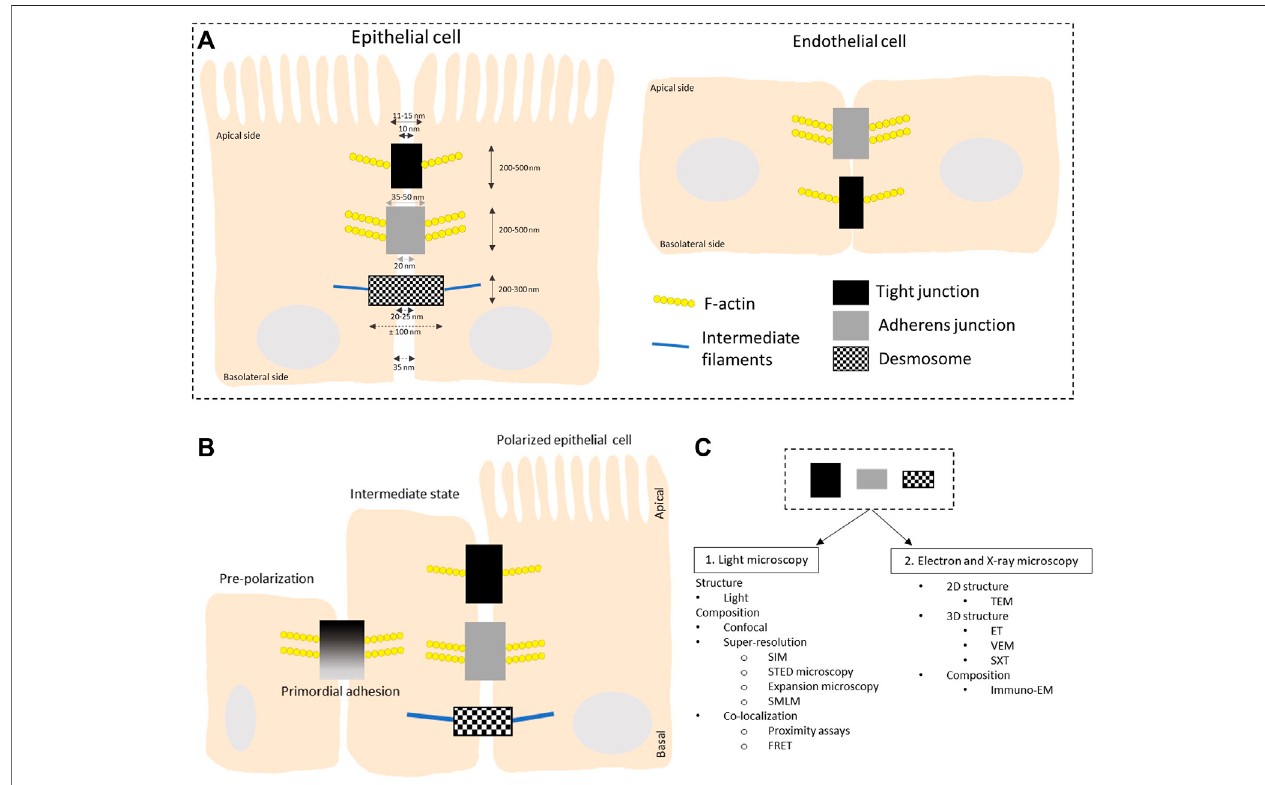
FIGURE 1 | Schematic overview of the organization of intercellular junctions in epithelial and endothelial cells. (A) Tight junctions, adherens junctions and desmosomes are present in polarized epithelial cells while no desmosomes are found in fl at endothelial cells. Tight and adherens junctions are connected to the actin cytoskeletonwhiledesmosomesconnecttointermediate fi laments. (B) Organizationofintercellularjunctionsduringthepolarizationofepithelialcells.Intheinitialstageof polarization, proteins like afadin and nectins are present. They recruit E-cadherin and junctional adhesion molecules (JAMs) to the lateral cell-cell contacts, called theprimordialadhesionsinimmatureepithelialcells.Thesematuretoformbelt-likeadhesionjunctionsandtightjunctionslocalizedattheapical-basalmembraneborder. The mechanism behind the polarization isreviewed in (Martin-Belmonte and Perez-Moreno,2012).The overallheight ofapolarized cellgrown in vitro is~15 μ m, fi gures are not on scale. (C) Overview of the different microscopy techniques that are discussed in this review to study the structure and composition of the three types of intercellular junctions. LM: light microscopy; TEM: transmission electron microscopy; ET: electron tomography; VEM: volume electron microscopy; SXT: soft X-ray microscopy; SIM: structured illumination microscopy; STED: stimulated emission depletion; SMLM: single molecule localization microscopy; FRET: Forster resonance energy transfer; Immuno-EM: immuno electron microscopy.